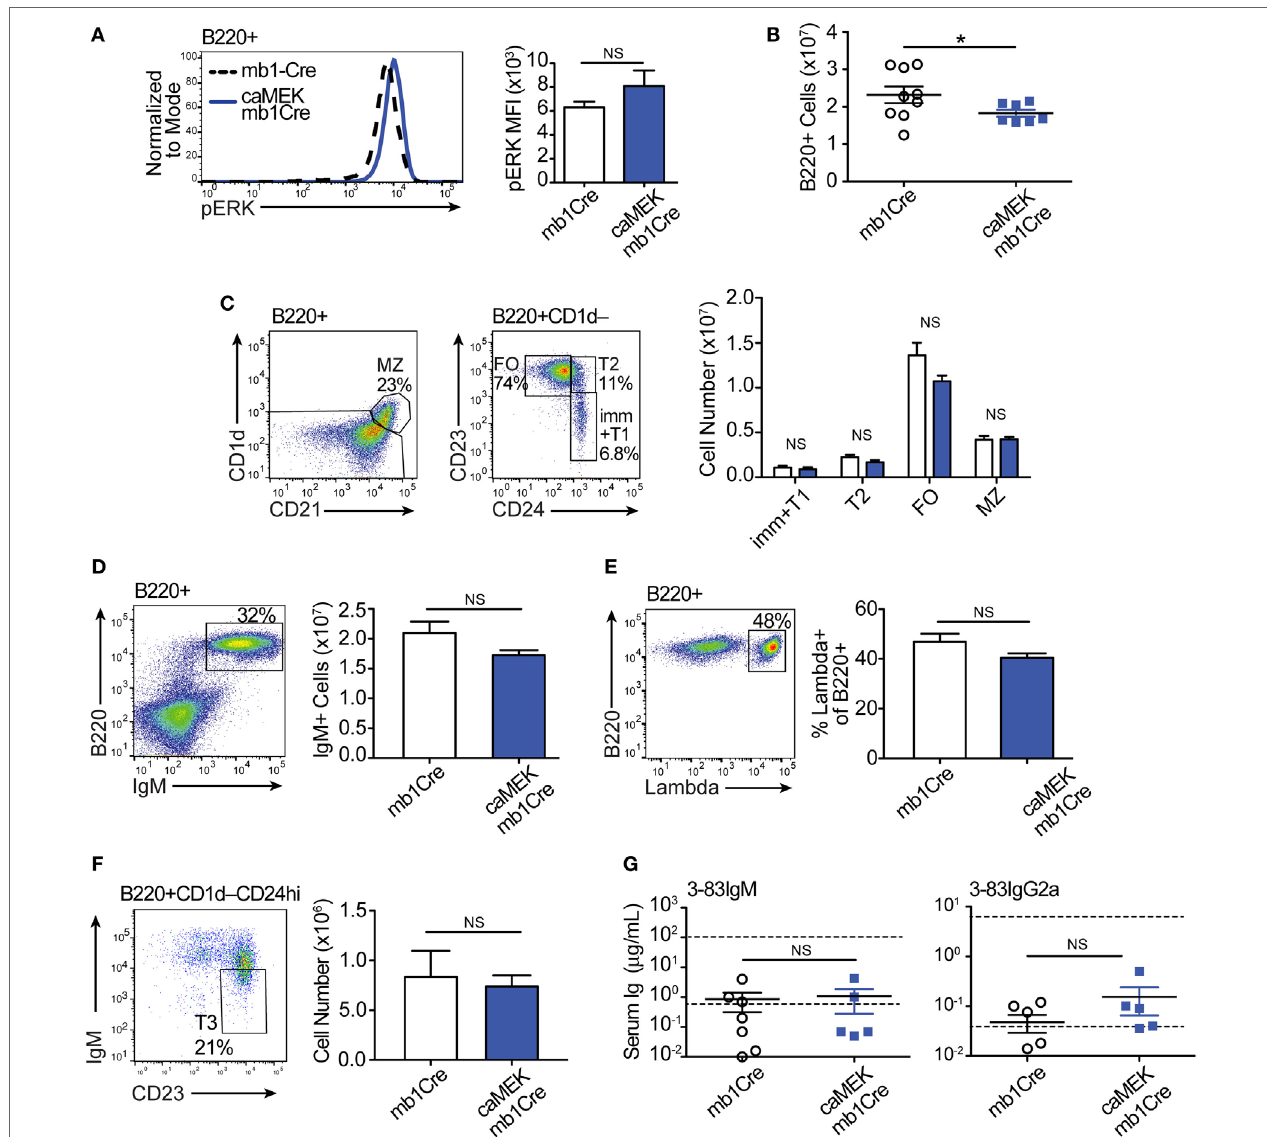
FigUre 5 | Constitutive extracellular signal-regulated kinase (ERK) activation does not break the central or peripheral tolerance of autoreactive 3-83Ig + B cells in vivo . (a) Representative histograms and bar graph quantification of phospho-ERK (pERK) levels in ex vivo B220 + B cells from the spleen of autoreactive 3-83Igi,H-2 b mb1Cre and R26-LSL-caMEK-GFP-mb1Cre mice. Cells were treated with pervanadate before pERK staining. (B) Absolute number of B220 + cells in the spleens of 3-83Igi,H-2 b mb1Cre and R26-LSL-caMEK-GFP-mb1Cre mice. (c) Gating strategy and bar graph quantification of splenic B cell populations from 3-83Igi,H-2 b mb1Cre and R26-LSL-caMEK-GFP-mb1Cre mice. B cell subsets were discriminated as: immature/transitional 1 B cells (B220 + CD1d – CD24 hi CD23 – ), transitional 2 B cells (B220 + CD1d – CD24 hi CD23 + ), follicular B cells (B220 + CD1d – CD24 lo CD23 + ), and marginal zone B cells (B220 + CD1d + CD21 hi ). (D) Gating strategy and quantification of IgM + B cell numbers from the spleens of 3-83Igi,H-2 b mb1Cre and R26-LSL-caMEK-GFP-mb1Cre mice. (e) Gating strategy and quantification of the percentage of λ + cells within B220 + B cells from the spleen of 3-83Igi-H-2 b mb1Cre and R26-LSL-caMEK-GFP-mb1Cre mice. For panels (a–e) , N = 9 total 3-83Igi,H-2 b -mb1Cre mice, and N = 7 total 3-83Igi,H-2 b -R26-LSL-caMEK-GFP-mb1Cre mice, analyzed in four independent experiments. (F) Gating strategy and quantification of T3 B cell numbers (CD23 + IgM lo ) within the transitional B cell population (B220 + CD1d – CD24 hi ) from the spleen of 3-83Igi,H-2 b mb1Cre and R26-LSL-caMEK-GFP-mb1Cre mice. In panels (a–F) , B cells from 3-83Igi,H-2 b R26-LSL-caMEK-GFP-mb1Cre mice were additionally gated on GFP + to analyze only the cells expressing caMEK. (g) Concentration ( μ g/mL) of 3-83IgM and 3-83IgG2a in the sera of 3-83Igi,H-2 b -mb1Cre controls ( N = 7) and 3-83Igi,H-2 b -R26-LSL-caMEK-GFP-mb1Cre mice ( N = 5). The bottom dotted lines represent background detection levels from a wild-type control and the top dotted lines represent Ig levels present in 3-83,H-2 d nonautoreactive (NA) positive control mice. * P ≤ 0.05; NS, not